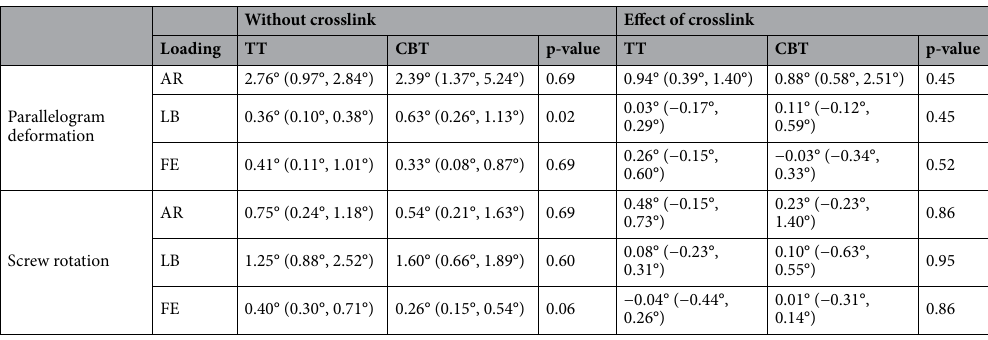
Table 2. Comparison of parallelogram deformation and screw rotation in segments instrumented with the traditional trajectory (TT) and segments instrumented with the cortical bone trajectory (CBT). The median (minimum, maximum) values are reported for each group. AR axial rotation, LB lateral bending, FE flexion–